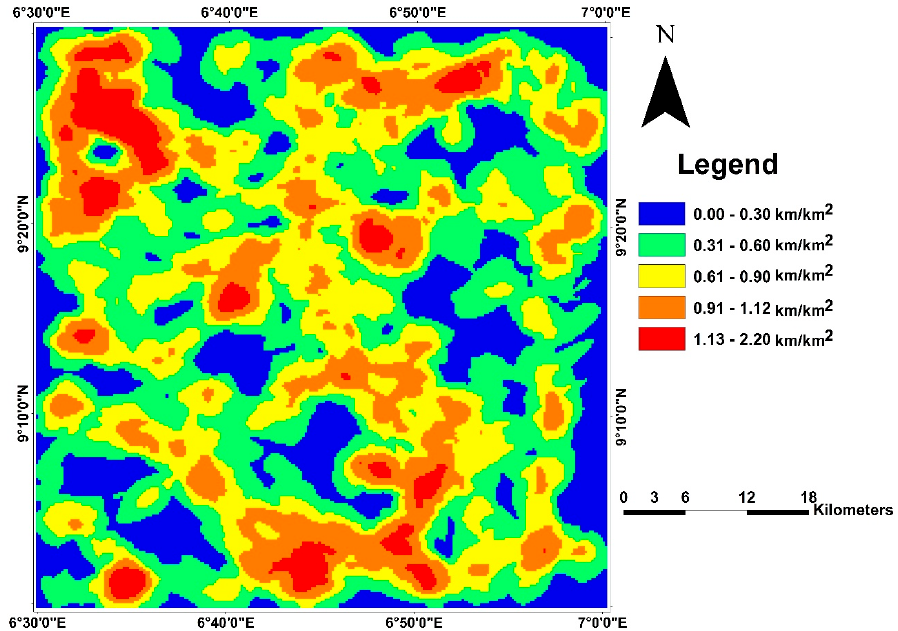
Figure 6. Composite Lineament density map of Paiko Sheet 185 North Central Nigeria. High lineament densities are shown in red, while low lineament densities are shown in blue.